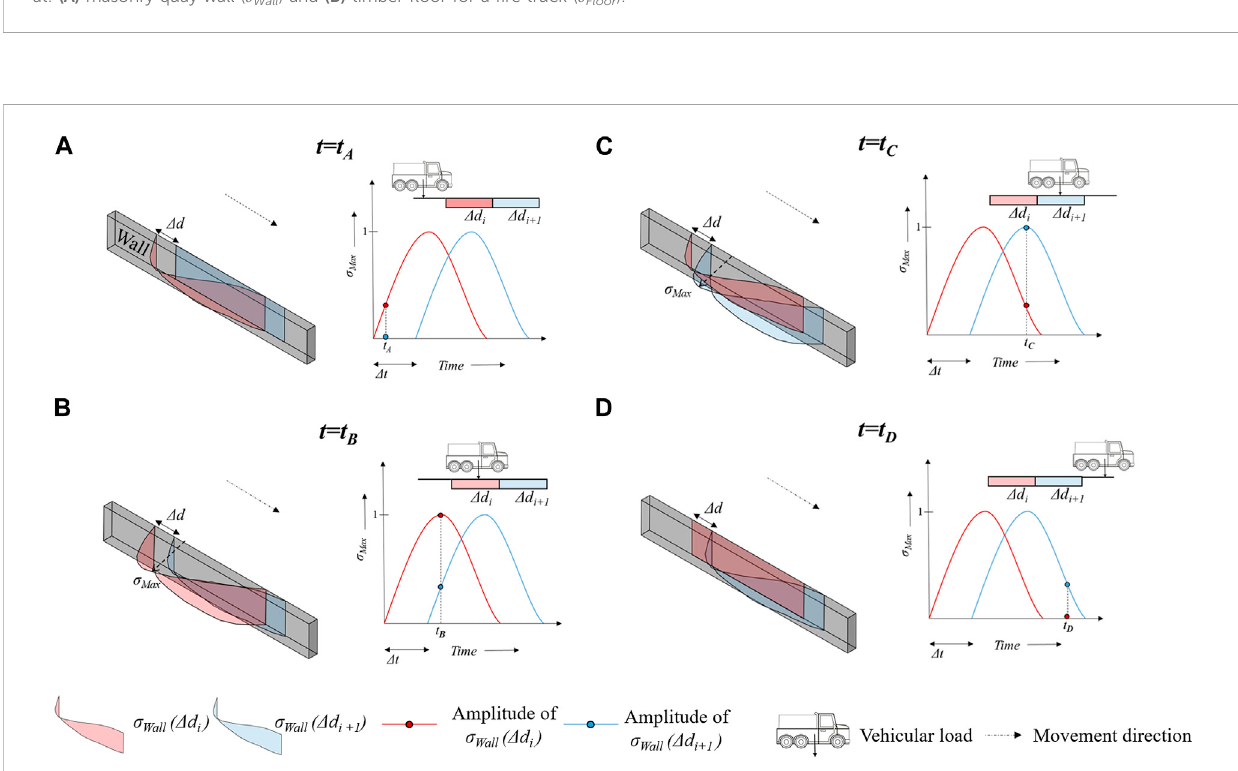
FIGURE 4 Schematicexplaining howrecordingsof step 1 are applied in step 2to thesoil-side faceof thewall inorder to dynamically simulate thepassage ofa vehicle: (A) approaching segment Δ d 1 ; (B) on top of segment Δ d 1 ; (C) on top of segment Δ d 2 ; (D) leaving segment Δ d 2